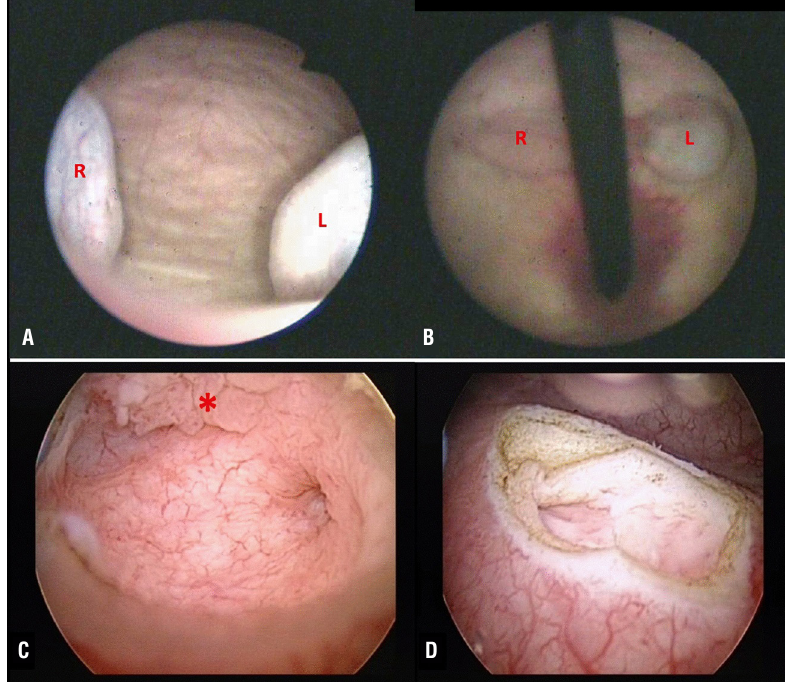
Figure 2 - A and B): Flexible cystoscopy was done and bilateral ureteroceles were seen but no suspicious lesion was seen as the lesion was enclosed within the left ureterocele (R- Right, L- Left). C) There is a papillary lesion on the inner surface sparing the proximal end of the ureterocele and the ureteric orifice (red asterisk). D) The right ureteric orifice was